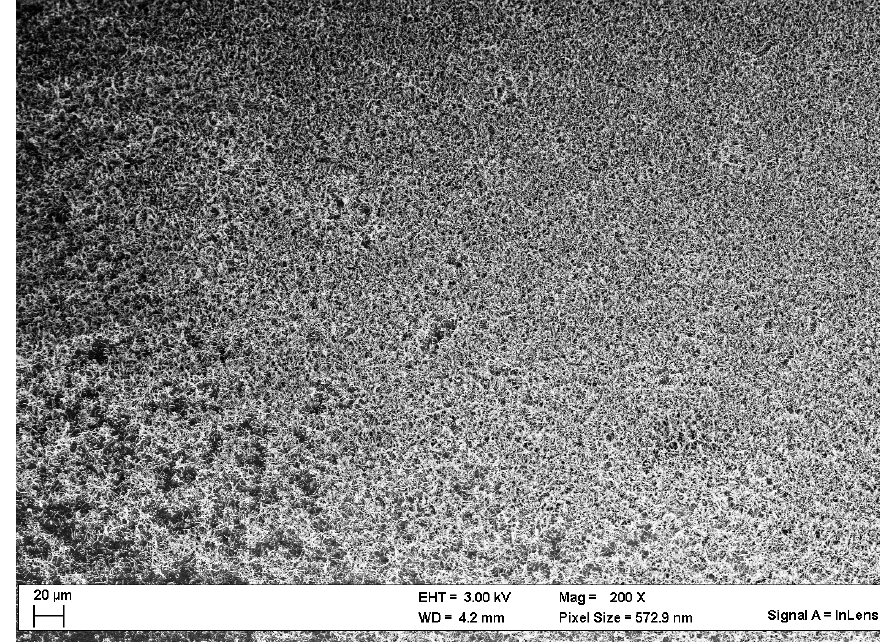
Figure 5. SEM image of lithium metal deposits on a copper foil, immediately after lithium deposition. Lithium was deposited for 360 s with a current density of 1 mA cm − 2 from 1 M LiDFOB in EC-DEC (3:7, by wt.).